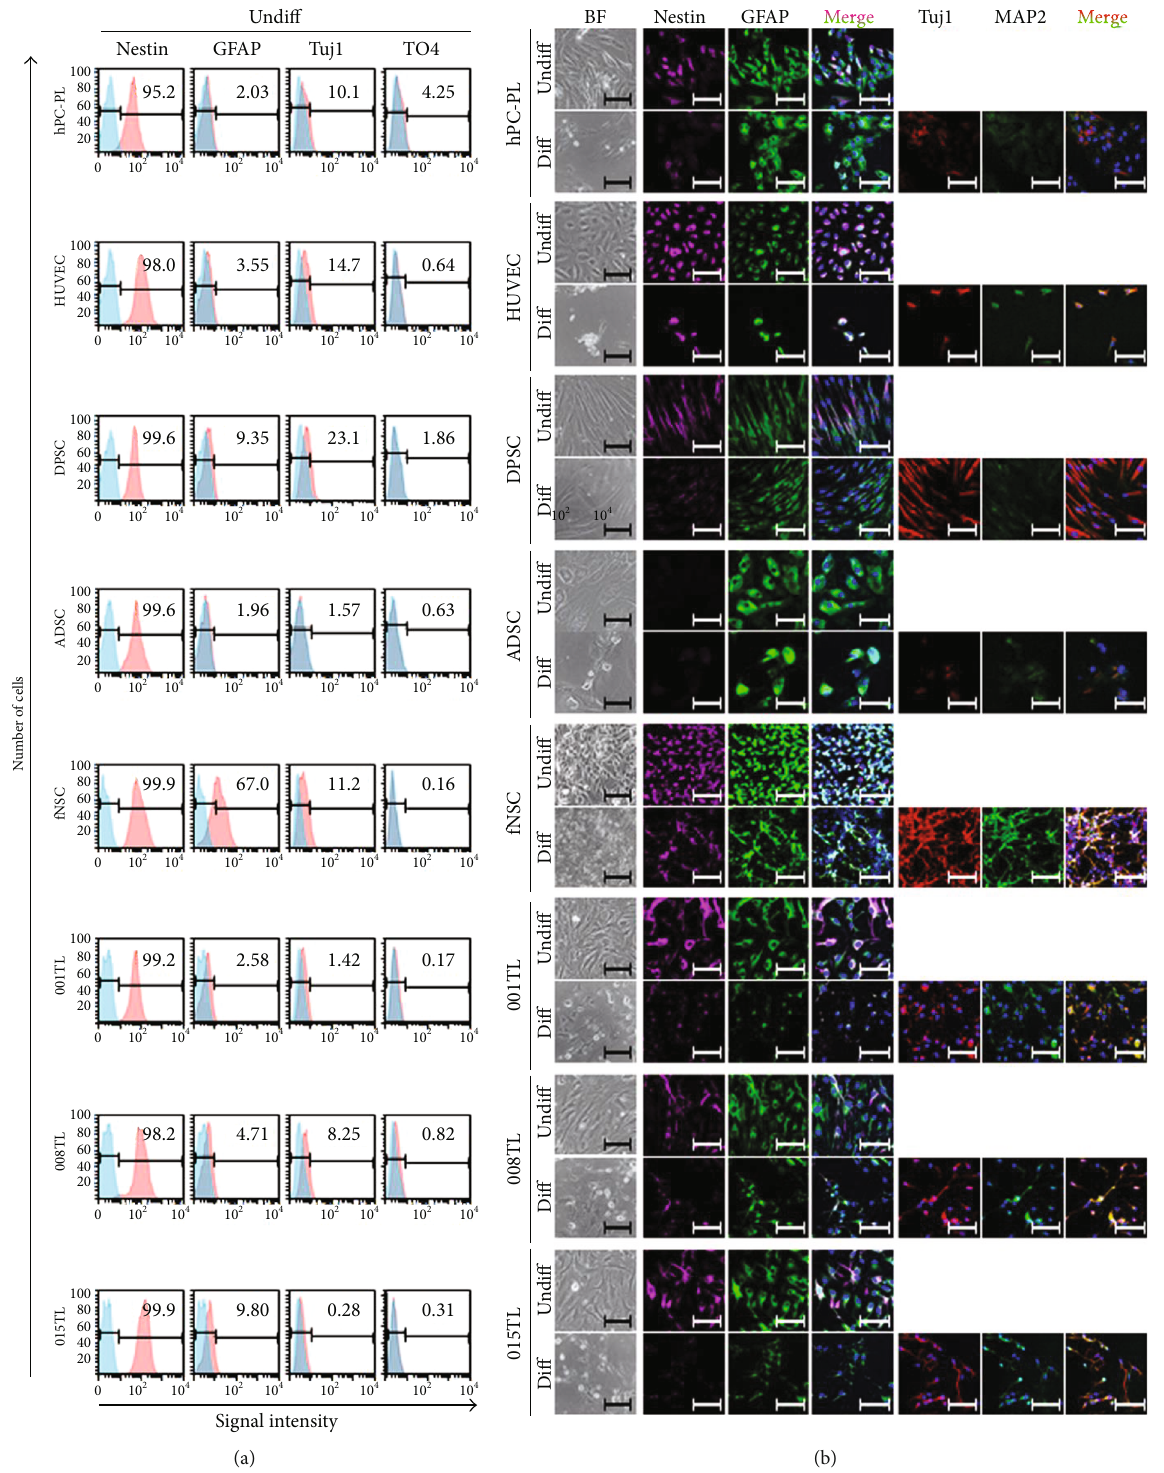
Figure 4: Expression of NSC-related markers and in vitro di ff erential potential into neural cells of ahMNCs. (a) Protein levels of NSC (Nestin) and neural cell (Tuj1 for neurons, O4 for oligodendrocytes, and GFAP for astrocytes) markers were analyzed by fl ow cytometry. Number in each panel indicated percent of marker-positive cells. (b) Expression of NSC (Nestin) and neural cell (Tuj1 and MAP2 for neurons and GFAP for astrocytes) markers of cells before (Undi ff ) or after neural di ff erentiation for 2 days (Di ff ) were analyzed by immunocytochemistry. BF: bright fi eld. Scale bars, 100 μ